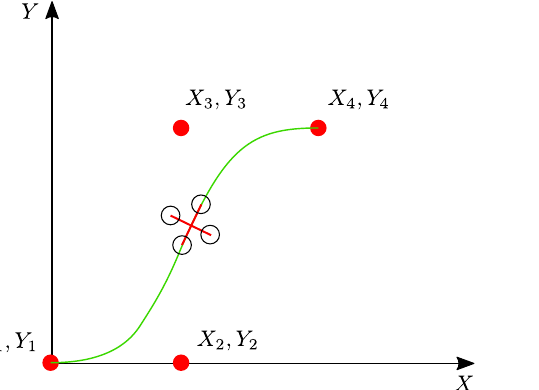
Figure 4. Cubic Bézier curve defined by a couple of pair of endpoints and control